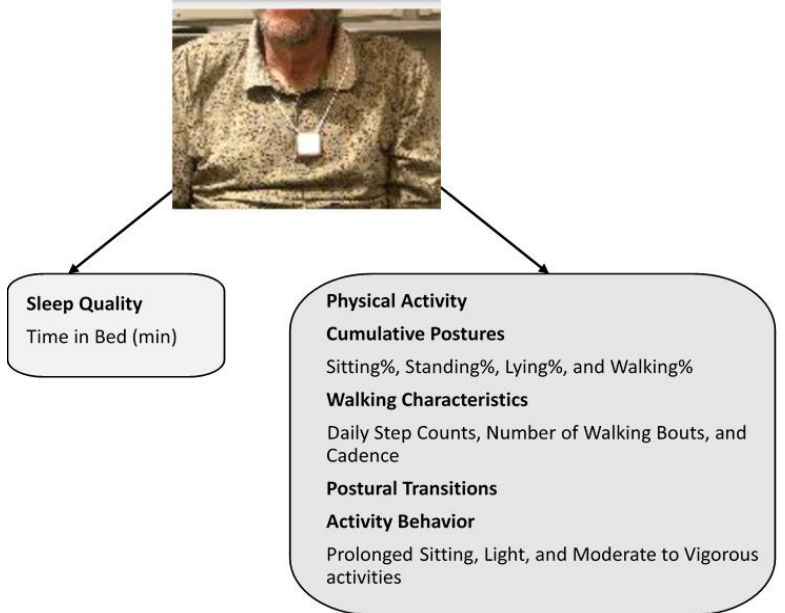
Figure 2. Participants wore the pendant sensor around the neck as shown above and the physical activity and sleep parameters that were extracted based on the validated algorithm are shown below, namely: time in bed, cumulative postures, walking characteristics, postural transitions, and activity behavior.